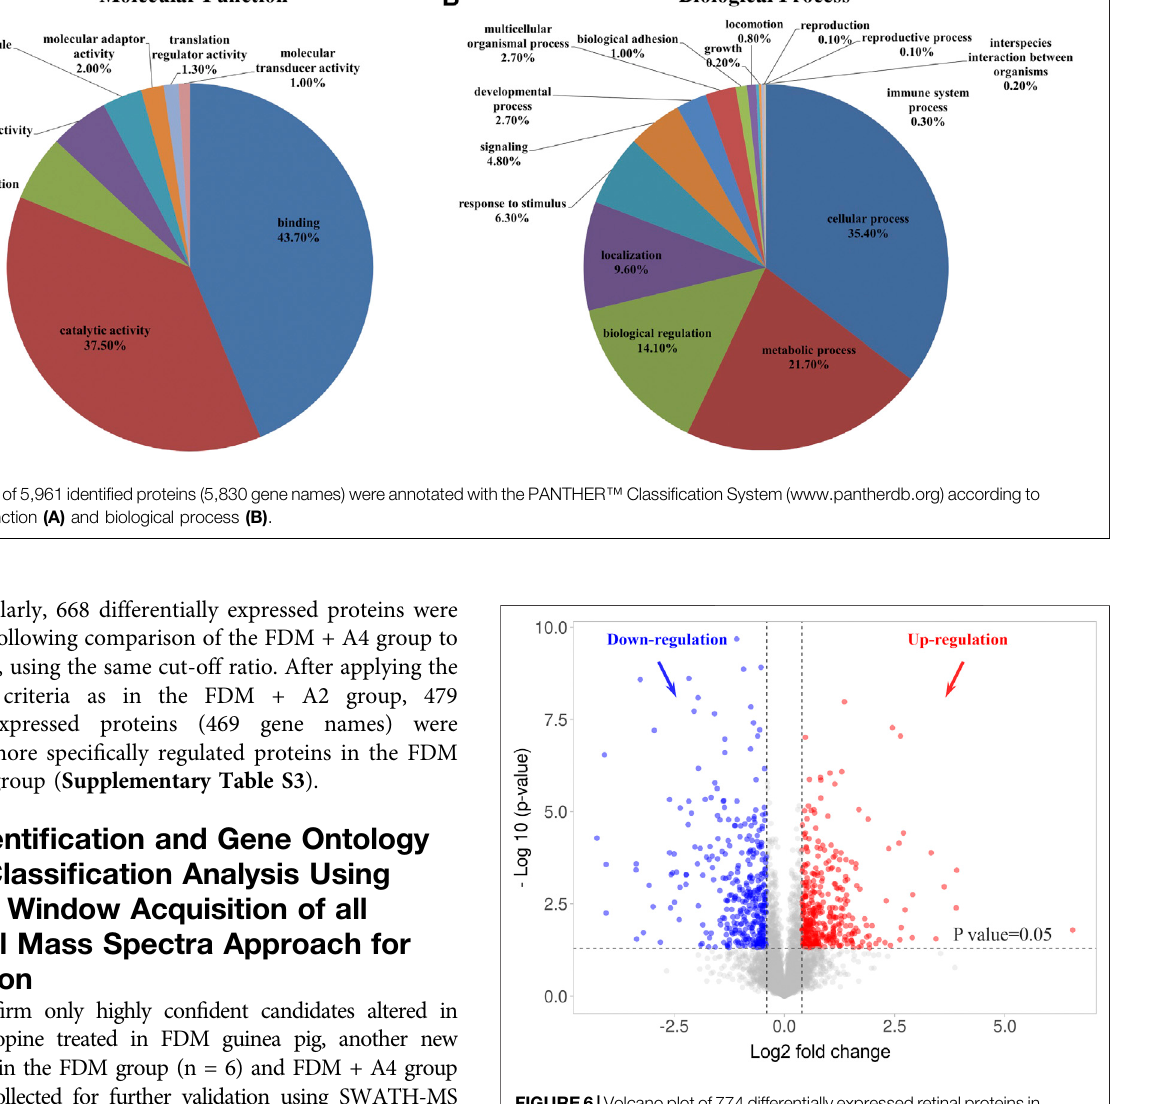
FIGURE6| Volcanoplotof774differentiallyexpressedretinalproteinsin 4-weeks atropine treated eyes (FDM + A4 group) compared to 4-weeks FDM eyes (FDM group) using a SWATH-MS based proteomics approach. Criteria for signi fi cant differential expression were as log2 ratio (FDM + A4/FDM) ≥ 0.43 or ≤ -0.43 (~1.40FC), p -value ≤ 0.05, welch